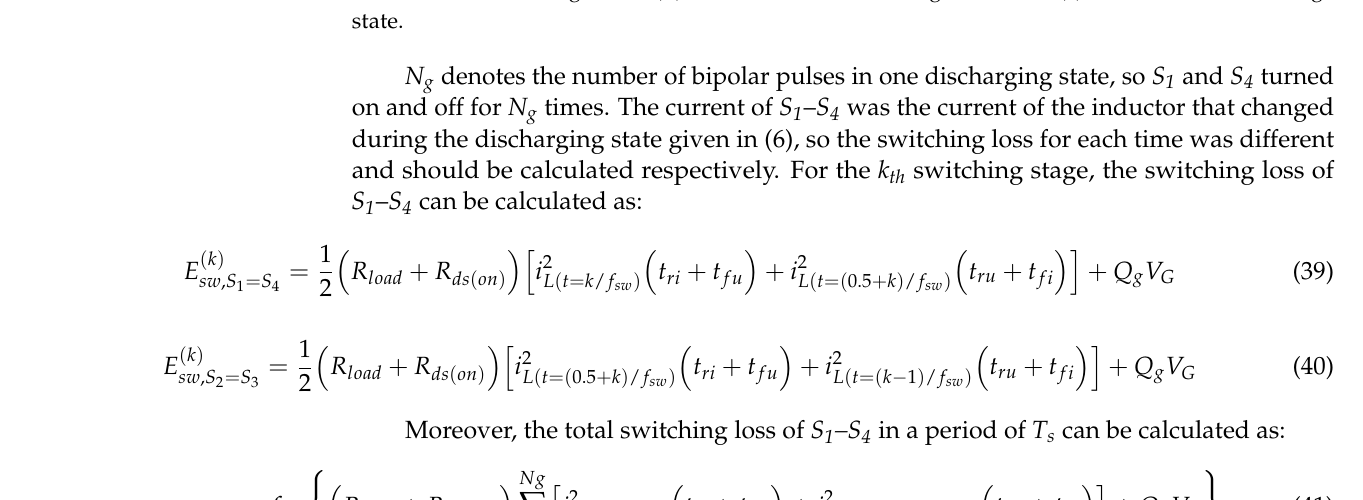
Figure 15. The communication between the P- and N-modes during the discharge state: ( a ) the P-mode of the discharge state; ( b ) dead-time of the discharge state, and ( c ) N-mode of the discharge state.